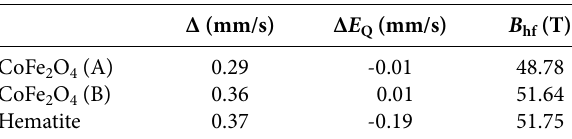
Table 2. Hyperfine parameters of CoFe 2 O 4 A and B site and hema- tite.